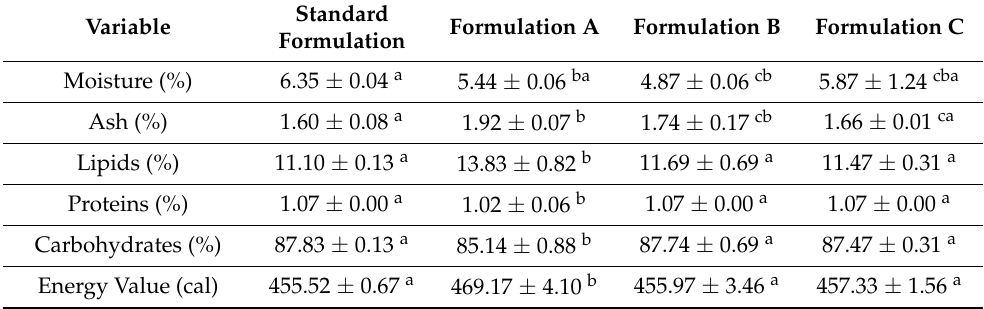
Table 6. Physicochemical composition and energy value of cookies prepared with standard formula- tion, formulation A (1% biosurfactant), formulation B (0.5% biosurfactant) and formulation C (0.25% biosurfactant) (data expressed as mean ± SD of triplicate